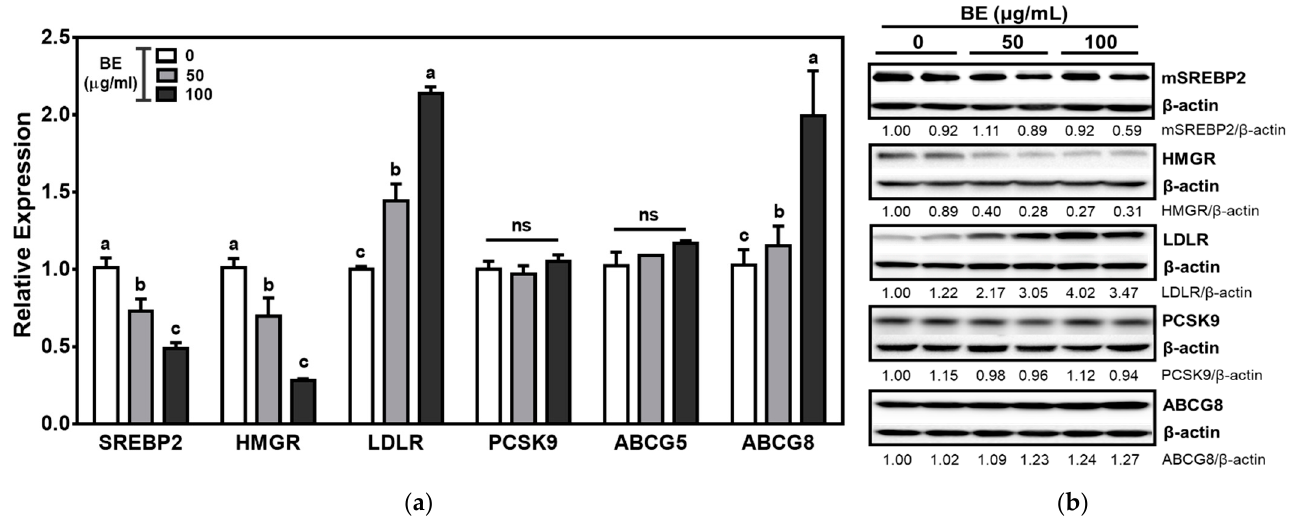
Figure 3. The genes involved in the intestinal cholesterol biosynthesis and TICE pathway in BE-treated Caco-2 cells. Cells were treated with 50 or 100 μ g/mL of BE for 24 h. ( a ) The mRNA expression was measured by qRT-PCR analysis. Data are expressed as relative expressions to control. Bars with different letters are significantly different ( p < 0.05), and ns indicates non-significance ( p > 0.05). Values are means ± S.E.M. n = 6. ( b ) The Western blot was conducted twice, and the representative image is shown. β -actin was used as a loading control. Densitometry analysis was performed to measure the relative intensity, and the values are shown under each band.